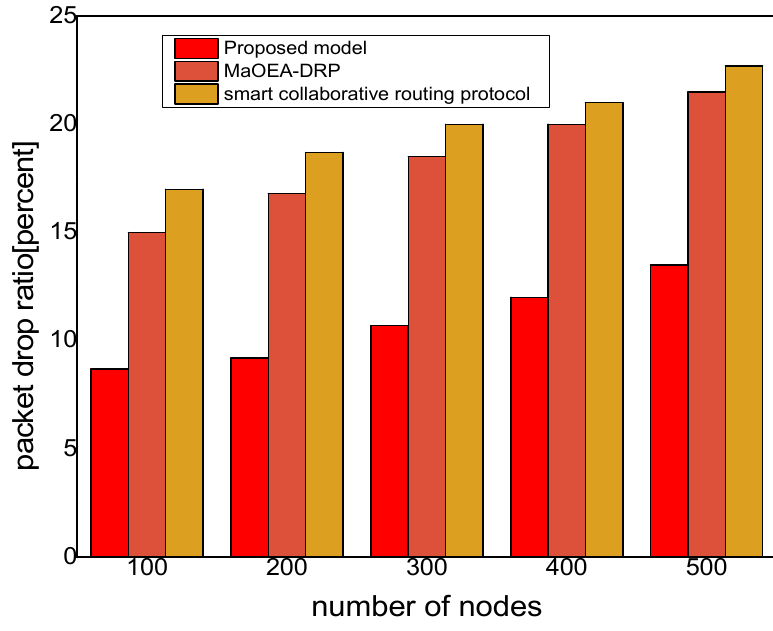
Figure 6. Packet drop ratio with the number of nodes.